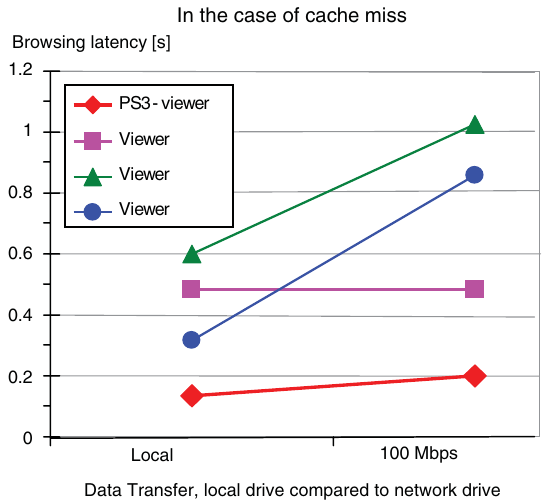
Fig. 10. Access Speed comparison between 3 PC based viewers and PS3 ® viewer:Network.Overthenetwork,thePS3 ® viewershoweda favorableresult.Thedifferencebetweenlocalandnetworkissmaller than all other PC based viewers that we have been